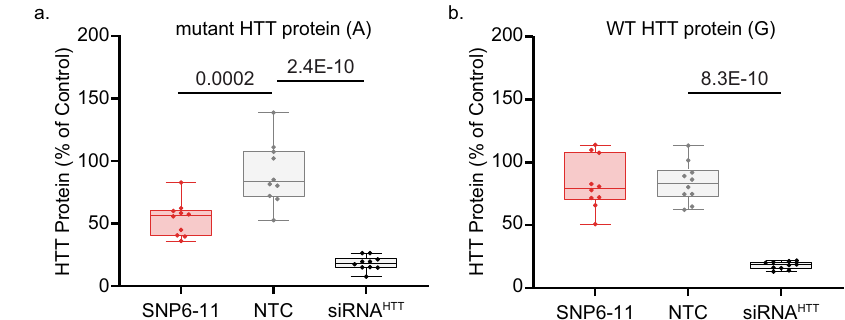
Fig.5|SNP6-11AsiRNAmaintainsselective-silencingofmutantHTTinneurons differentiated from human iPSCs. Western blot analysis of HD109 neurons, which are heterozygous at SNP2273, showed lowering of mutant HTT a compared to wild-type HTT b with SNP6-11. Cells were treated for 5 days with 3.0 µ M siRNA. Pixelintensity ofmutant or wild-type HTT wasstandardizedto thatofvinculinand reported as a percentage of untreated. Non-selective targeting with siRNA HTT